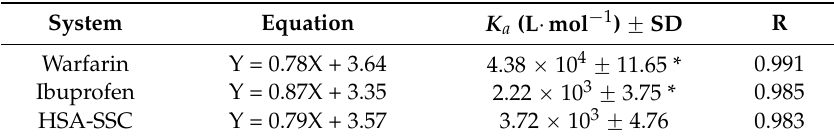
Table 3. Binding reactive parameters in site competitive experiments.